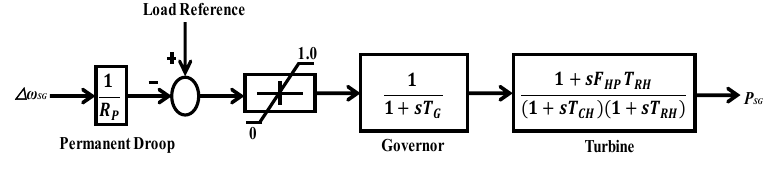
Figure 2. Exciter model of synchronous generators (SGs).